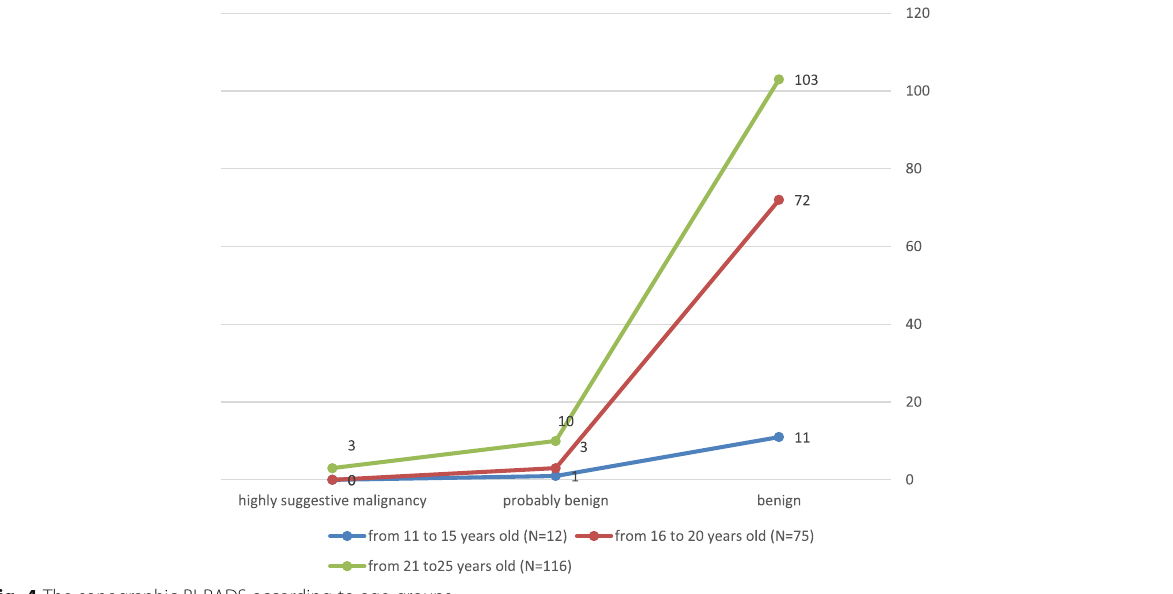
Fig. 4 The sonographic BI-RADS according to age